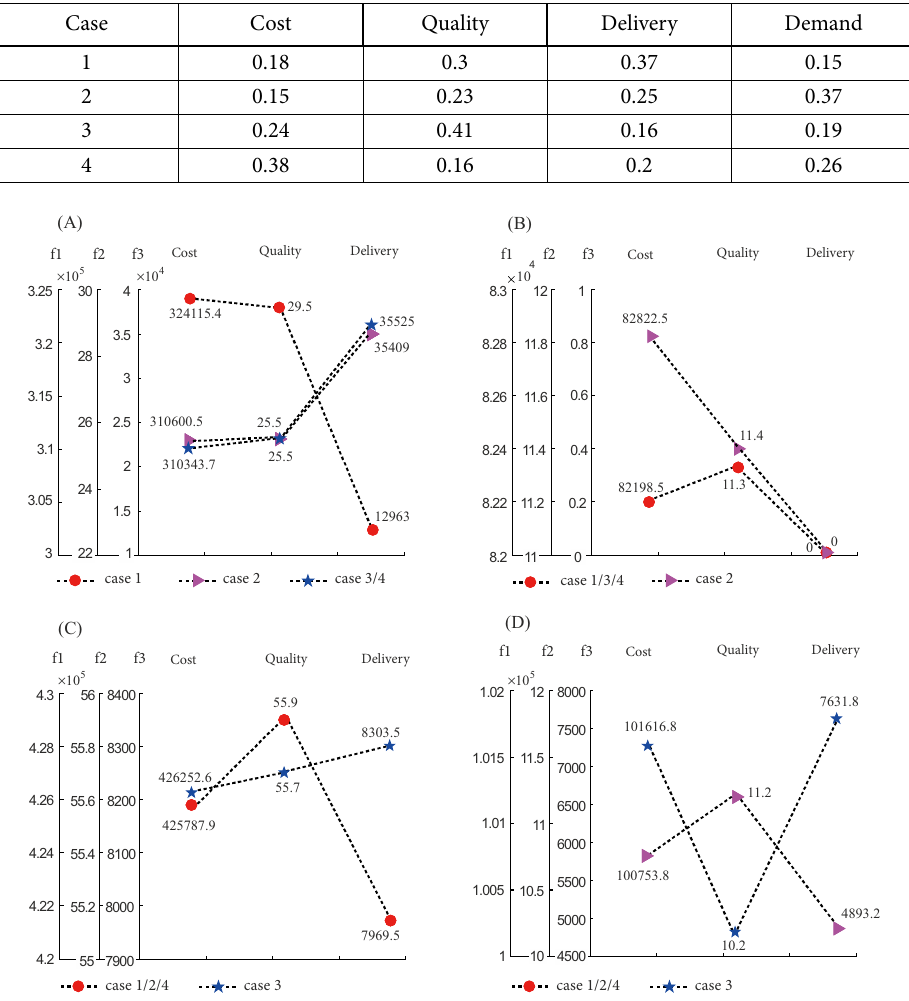
Figure 7. Solutions of the four cases – for the three objectives of cost, quality and delivery Note: A – intake air pressure sensor; B – oil injection nozzle; C – oxygen sensor; D – crankshaft; f1 – cost; f2 – unqualified items; f3 –